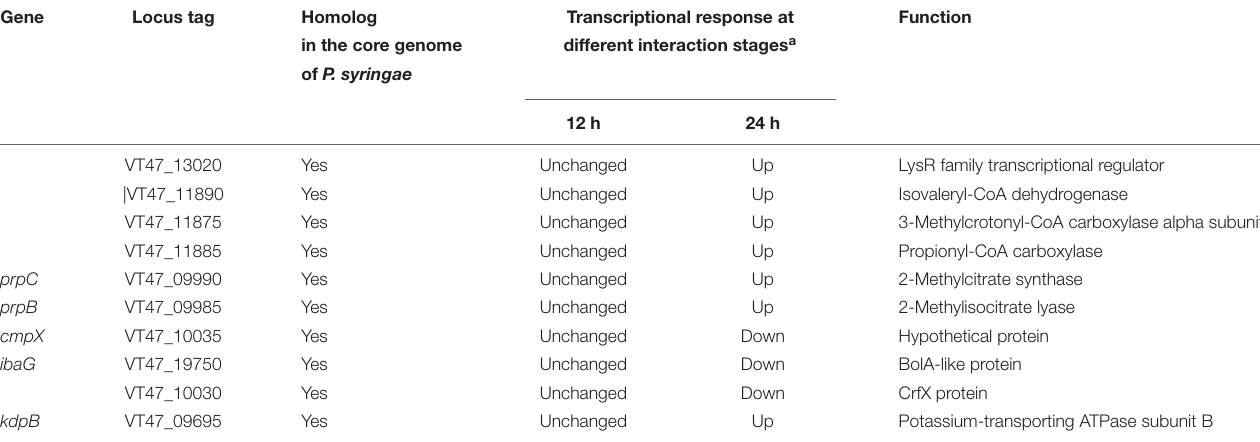
TABLE 2 | Homologs of P. aeruginosa PA14 and PAO1 nematicidal genes in P. syringae MB03 showing differential transcriptional response. Gene